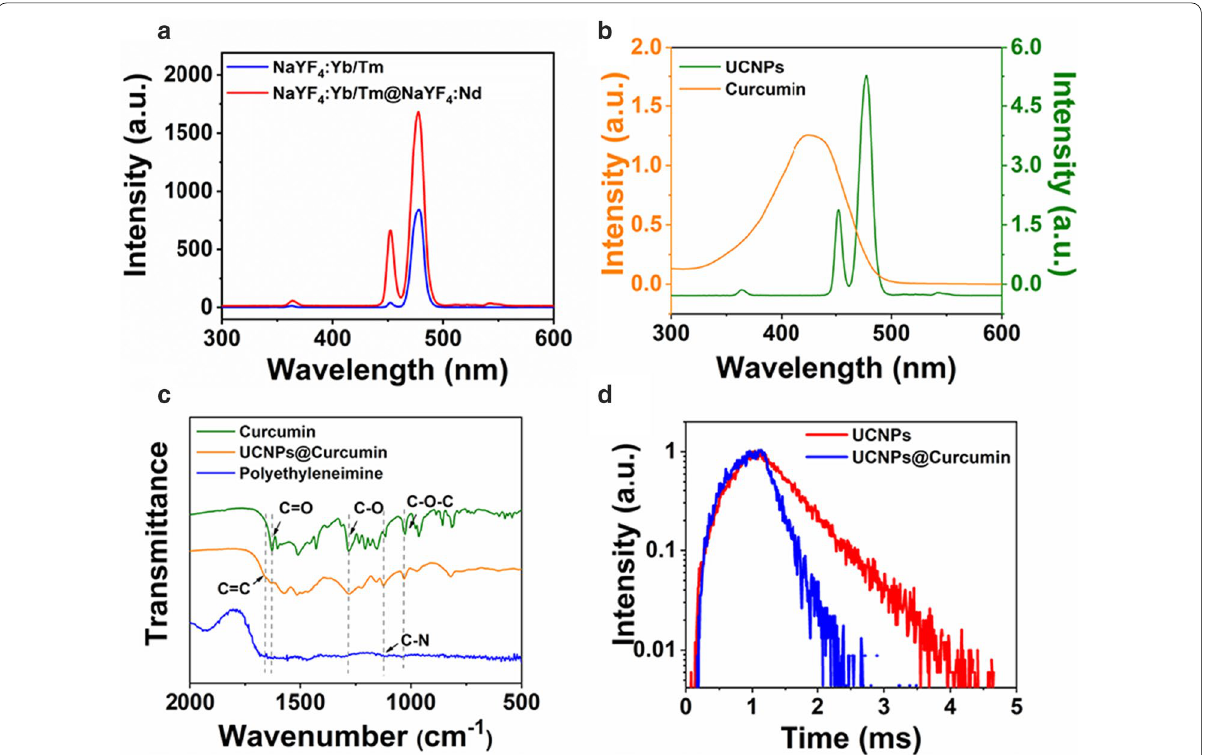
Fig. 2 a Fluorescence spectrum of core–shell NaYF 4 :Yb/Tm@NaYF 4 :Nd excited by 808 nm, b fluorescence spectrum of UCNPs and UV–vis absorption spectrum of curcumin, c FTIR spectra of UCNPs@Curcumin, curcumin and PEI, d time‑resolved fluorescence spectra of UCNPs and